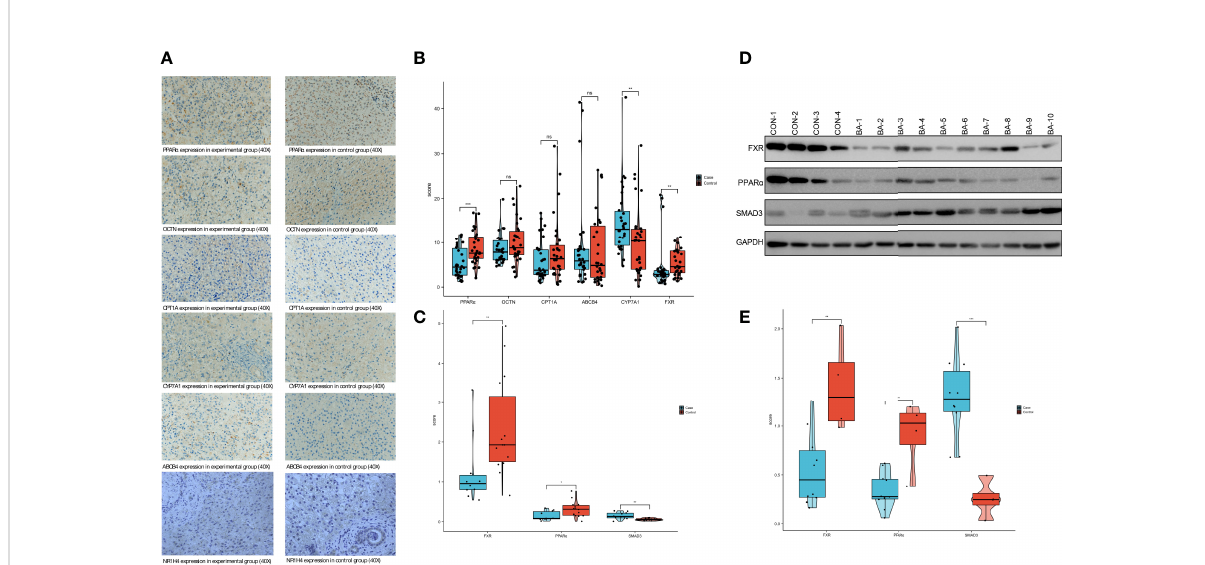
FIGURE 6 PPAR a and NR1H4 (FXR) expression in the BA and control groups (A) IHC fi ndings in the BA and control groups. (B) Semi-quantitative analysis of IHC in pathological sections using ImageJ software. (ns, not signi fi cant, *P<0.05, **P<0.01, ***P<0.001). (C) Veri fi cation of PPAR a 、 FXR and SMAD3 expression in liver using RT-qPCR. The P values are labeled using asterisks (ns, no signi fi cance, *P < 0.05, **P < 0.01,***P < 0.001). (D) The expression of 3 mRNAs related protein in liver tissue detected by Westernblot. (E) The WB results were semi-quantitatively analyzed by ImageJ